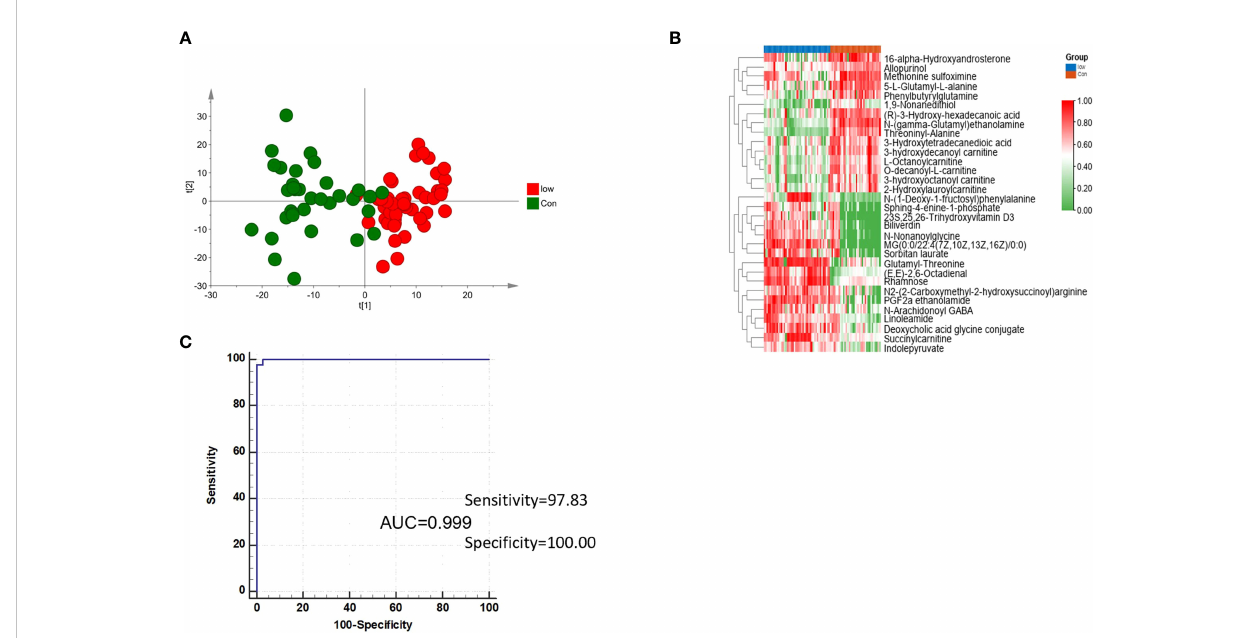
FIGURE 3 Analysis of metabolites in the low-grade NMIBC group vs . the control group. (A) Score plot of the OPLS-DA model analysis of the low-grade NMIBC group and the control group. (B) Relative intensity of differential metabolites in the low-grade NMIBC group and the control group by metabolite panels of L-octanoylcarnitine, PGF2a ethanolamide, and threoninyl-alanine. (C) ROC plot of the low-grade NMIBC group and control group based on the discrimination